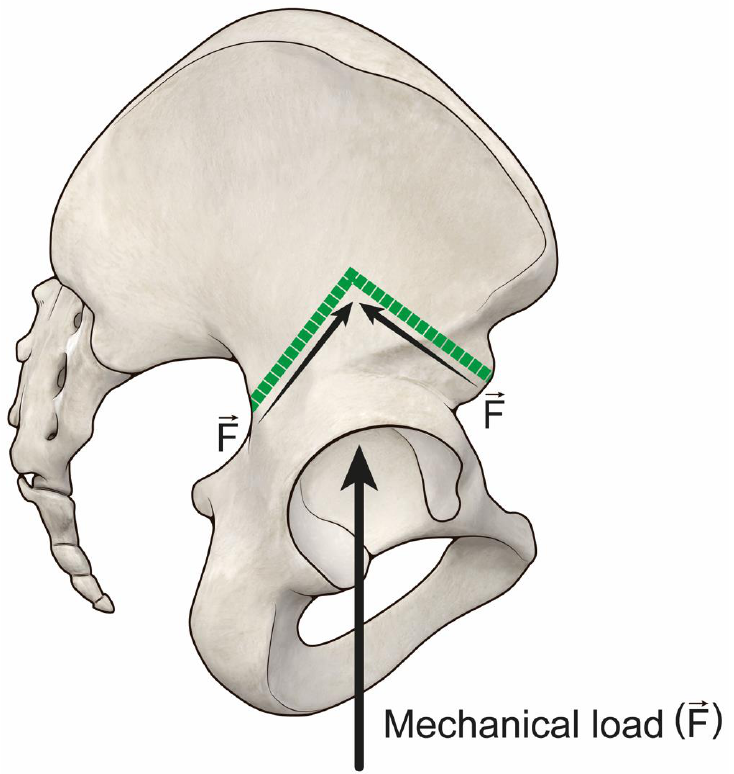
Figure 7. Biomechanics of a multiplanar osteotomy: the mechanical load is distributed along the two osteotomy lines with limited vertical shear